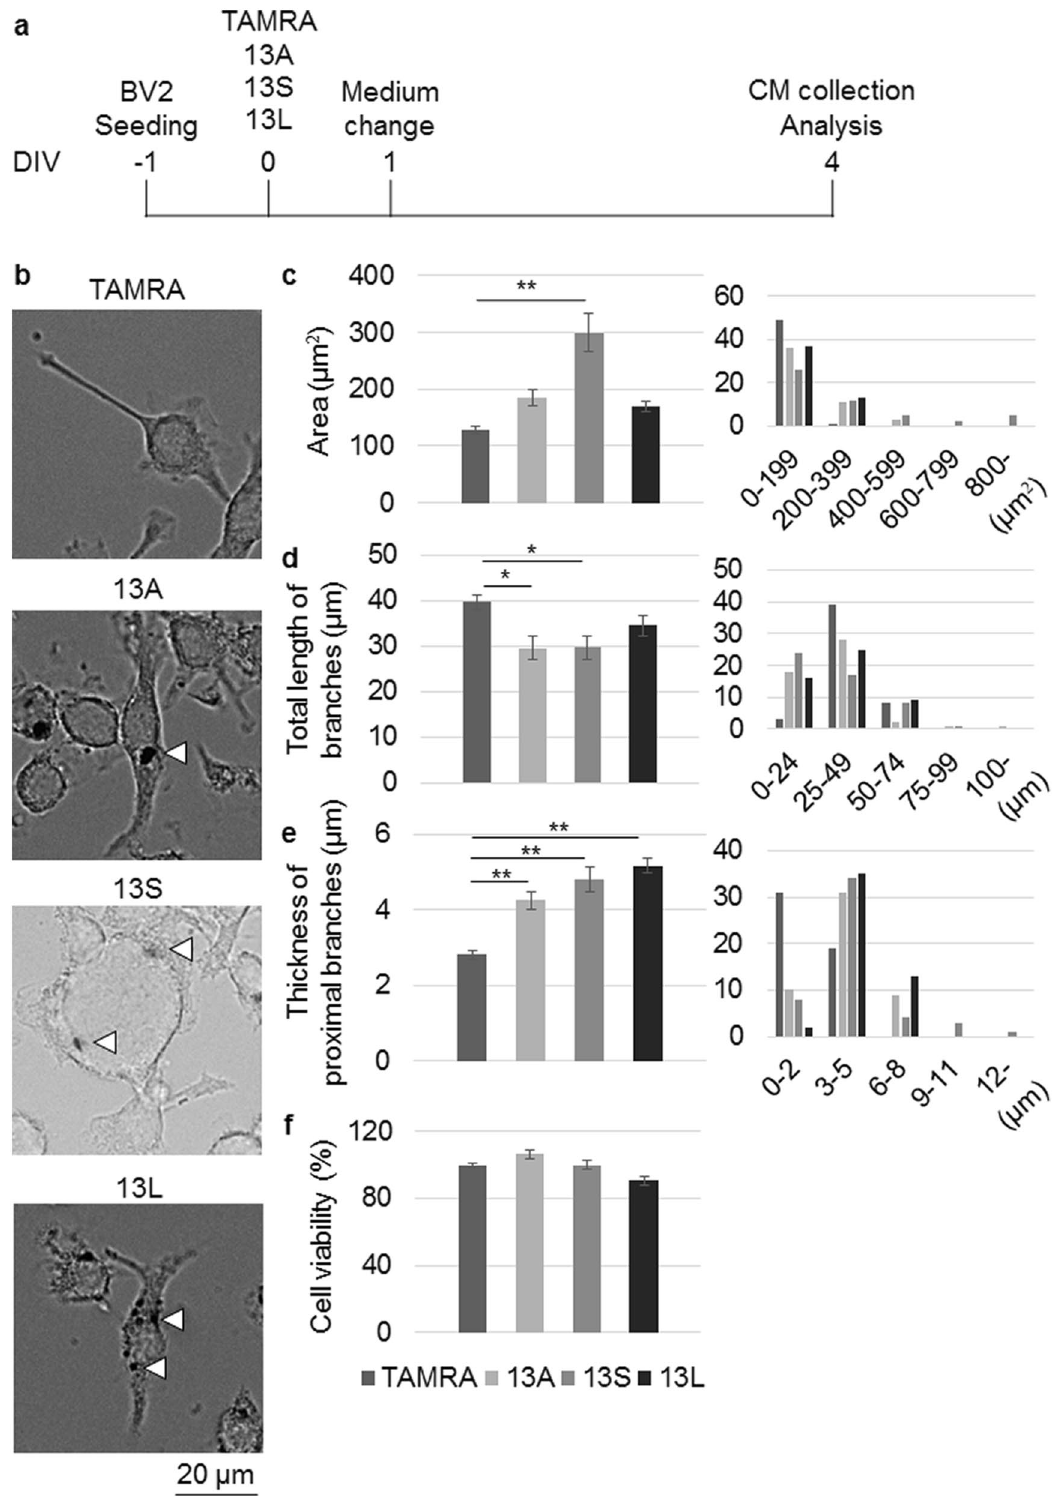
Figure 2. Morphological changes of BV2 microglia by addition of 13A, 13S and 13L. ( a ) Timing of addition of 13A, 13S or 13L and collection of CM. ( b – e ) Representative images ( b ) and quantification of the area ( c ), total length of branches ( d ) and thickness of proximal branches ( e ) of BV2 microglia with TAMRA, 13A, 13S or 13L (n = 50 cells, each from 3 independent experiments). Arrowheads indicate aggregates. x-axis and y-axis of histograms (right panels) indicate distribution of the values and numbers, respectively. ( f ) Viability of BV2 cells with TAMRA, 13A, 13S or 13L. The values relative to that of TAMRA are expressed. Error bars represent SE. ANOVA, *p < 0.05; **p < 0.01. Scale bar 20